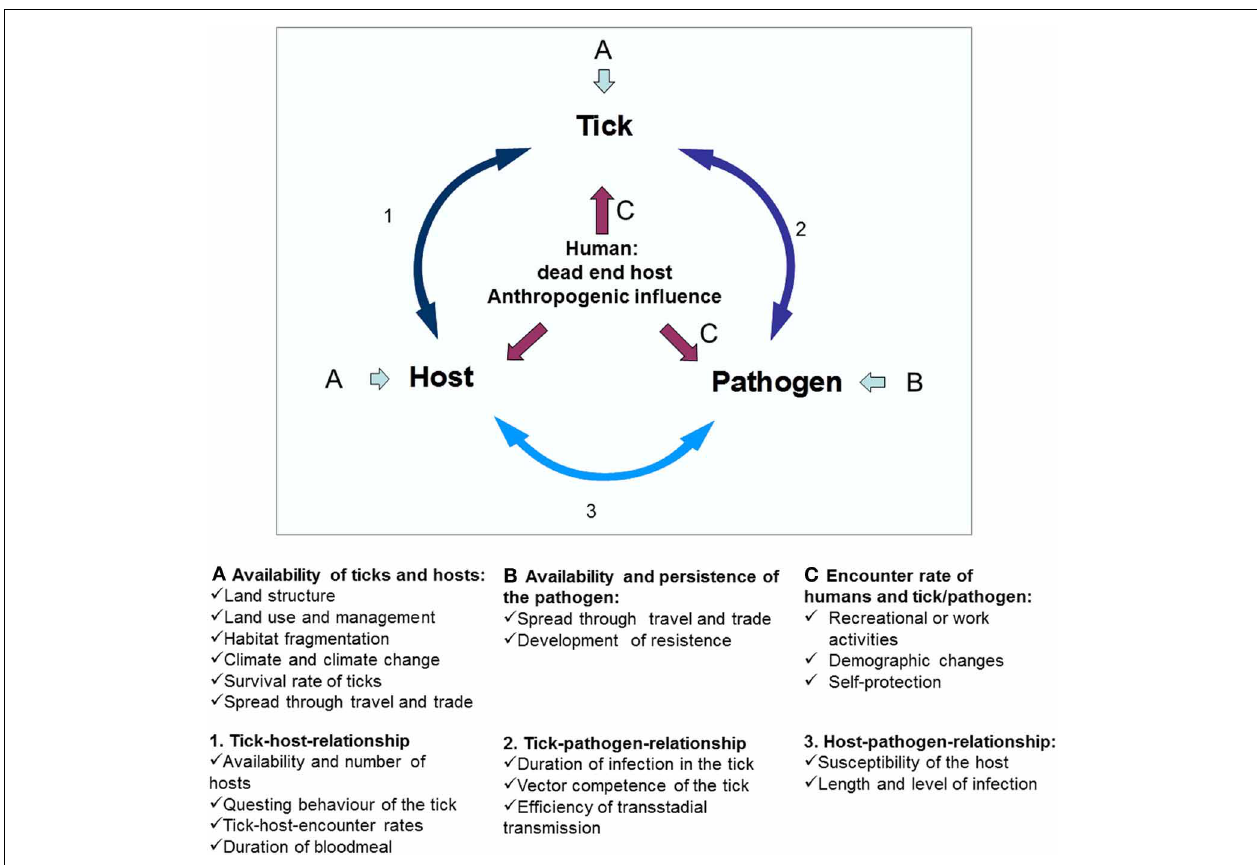
FIGURE 1 | Direct, indirect, and anthropogenic influences on the tick-host-pathogen relationship of Anaplasma